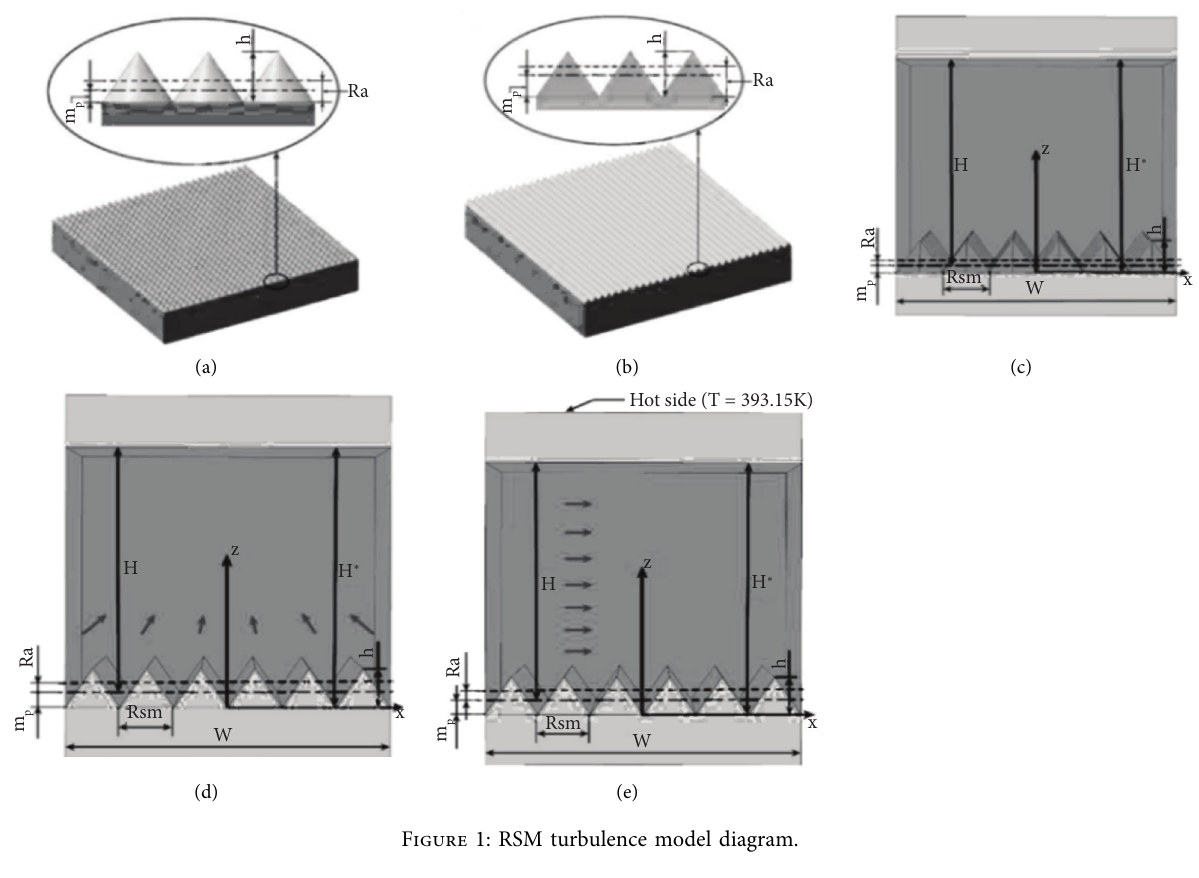
Figure 1: RSM turbulence model diagram.